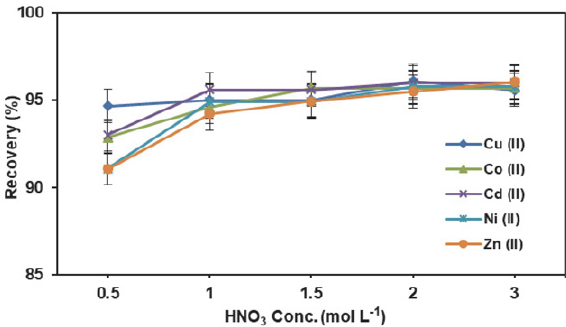
Figure 2. Effect of HNO 3 concentration on elution efficiency of Cu(II), Co(II), Cd(II), Ni(II) and Zn(II) ions from 100 mg of Fe 3 O 4 @PTh MNPS (eluent vol.: 5.0 mL, n =